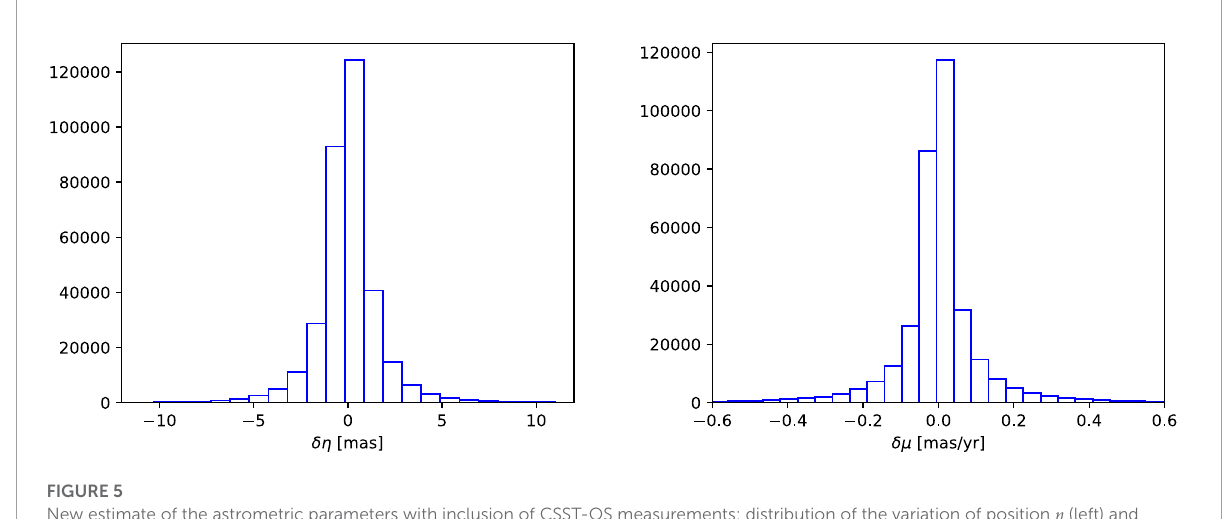
FIGURE 5 New estimate of the astrometric parameters with inclusion of CSST-OS measurements: distribution of the variation of position η (left) and proper motion μ (right).